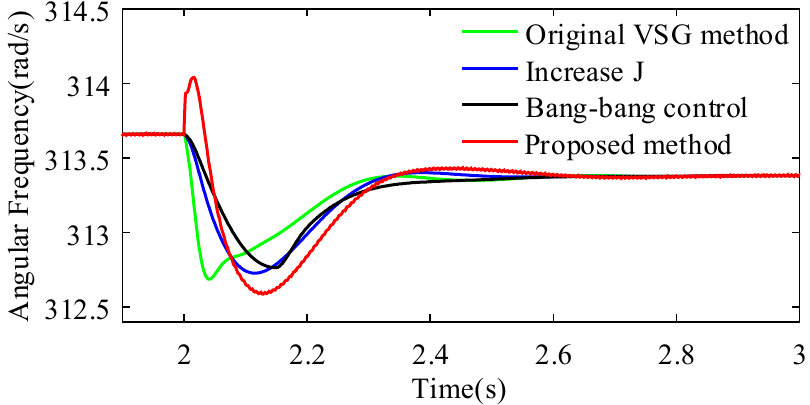
performances of different methods are displayed in Figures 15 and 16, respectively.